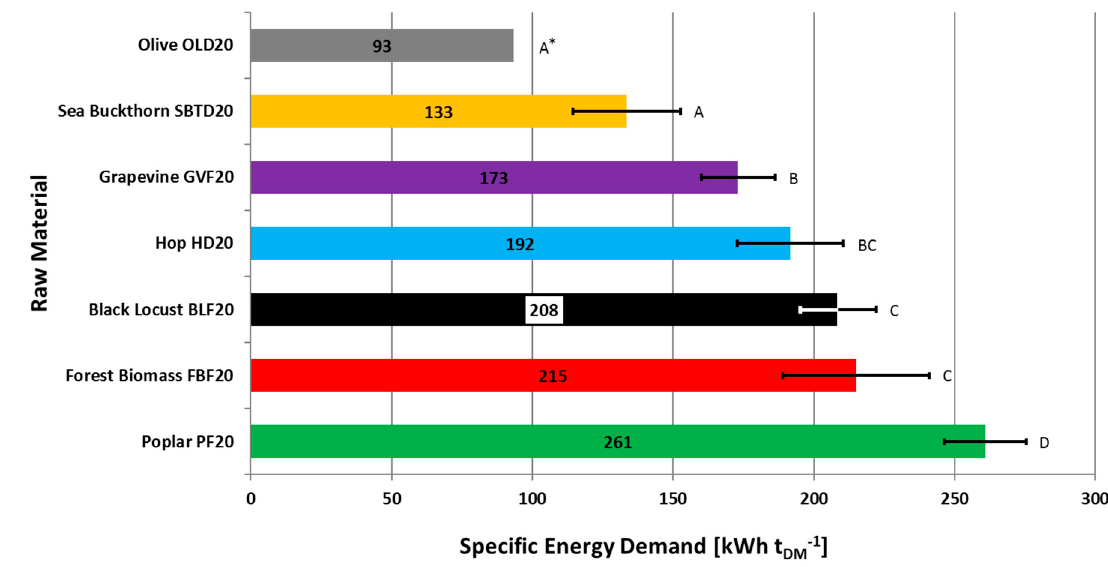
Figure 4. Specific energy demands and standard deviation at 20 mm aperture setting by the extruder at ATB in kWh t DM − 1 at moisture content of approx. 50% for seven different types of raw material. Different letters indicate significant differences between raw materials for α = 0.05. * only standard error was available for significance tests, standard deviation could not be calculated with only one measurement.